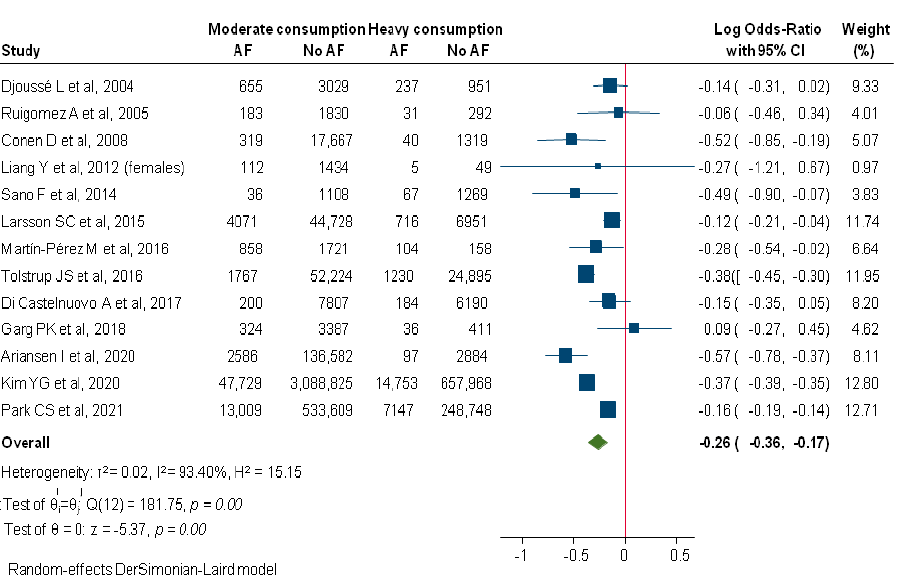
Figure 3. Comparison between moderate and low alcohol consumption regarding incident AF. AF, Atrial Fibrillation.